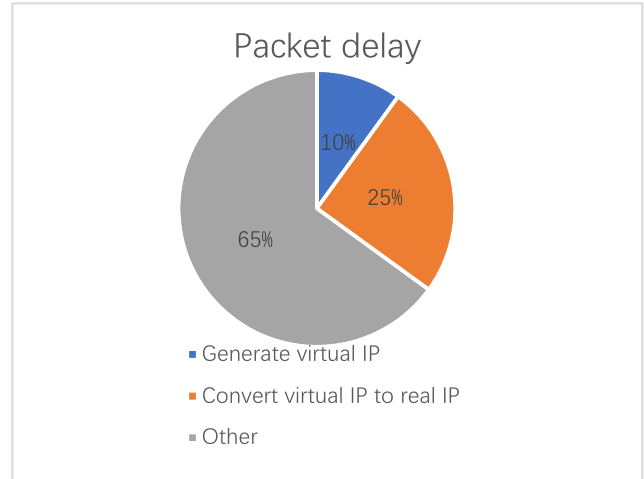
Figure 8. Package delay.